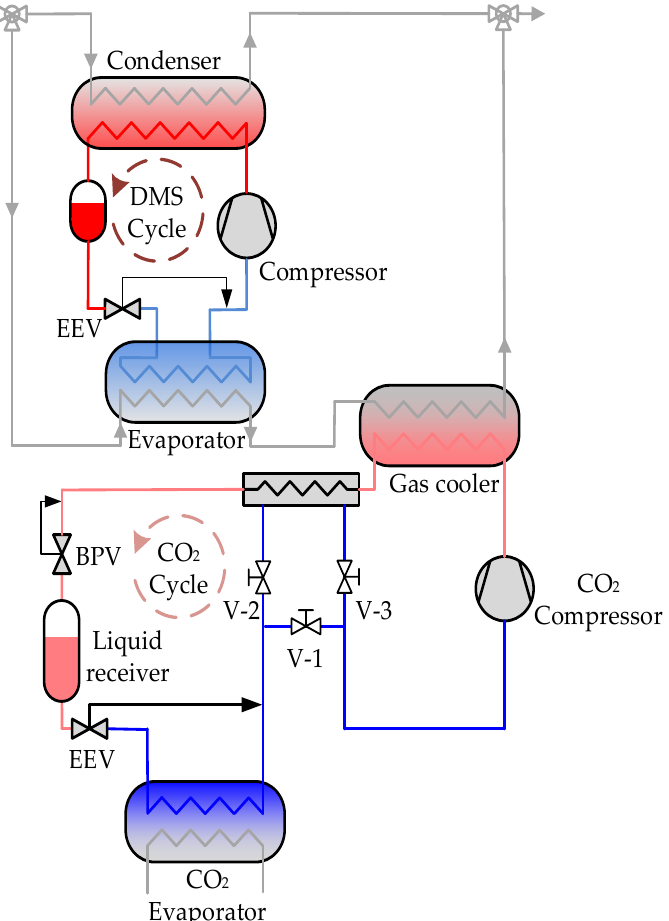
Figure 3. DMS cycle combined with a transcritical CO 2 heat pump with a water stream splitting strategy proposed by [30].